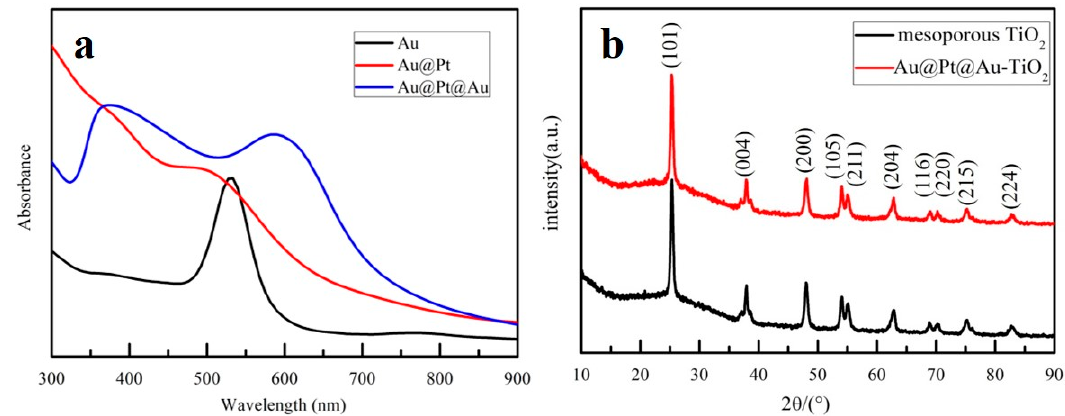
Figure 3. ( a ) Optical absorption curves of Au NPs, Au@Pt core-shell NPs, and Au@Pt@Au core-shell NPs dispersed in deionized water; ( b ) X-ray diffraction (XRD) atlas of TiO 2 and TiO 2 incorporated with Au@Pt@Au core-shell NPs.